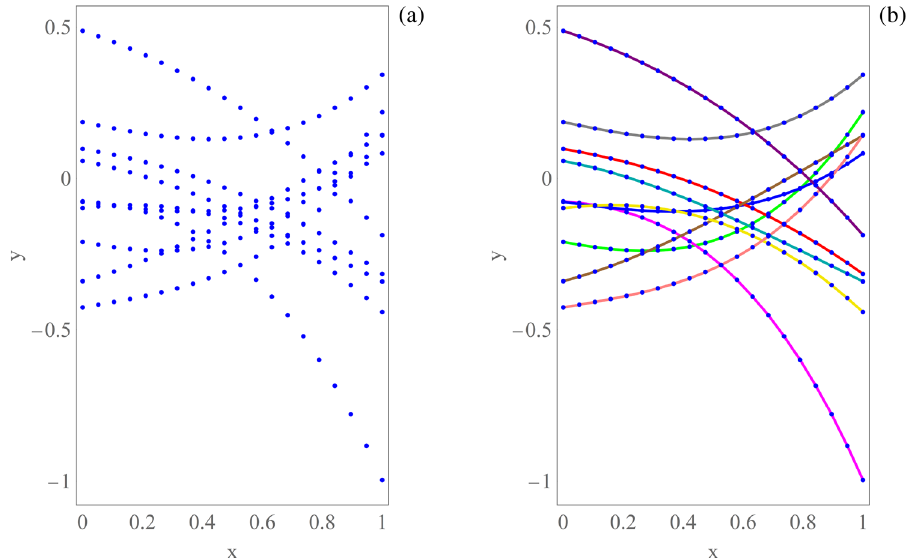
Figure 4. Curve coloring in the case of smooth generic curves. ( a ) Original sampled curves. ( b ) Possible desired